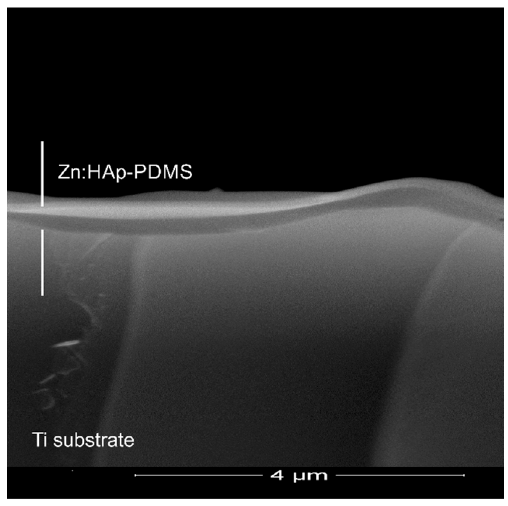
Figure 4. SEM images of the transversal cross section of a Zn:HAp-PDMS layer deposited on a rough Ti surface substrate.